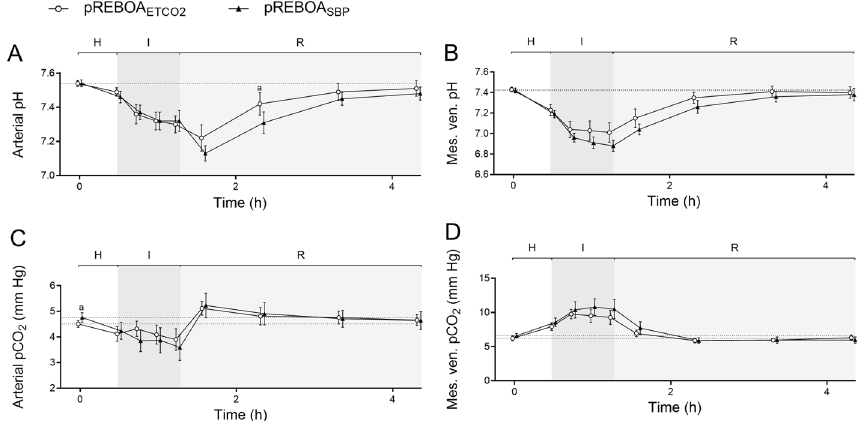
Fig. 3 Arterial and mesenteric venous pH ( A , B ) and pCO 2 ( C , D ) in anesthetized, mechanically ventilated pigs undergoing hemorrhage (H), intervention (I) using either end-tidal carbon dioxide (ETCO 2 ) targeted partial resuscitative endovascular balloon occlusion of the aorta (pREBOA, pREBOA ETCO2 , n 10) and proximal = systolic blood pressure targeted pREBOA (pREBOA SBP , n 10) and subsequent reperfusion (R). a Denotes = statistical difference between the groups at given timepoint. Data are means (95% confidence interval). The dotted line represents